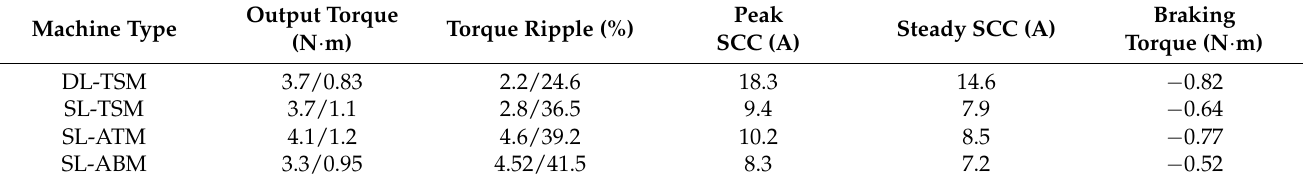
Table 5. Electromagnetic performance under three-phase short circuit